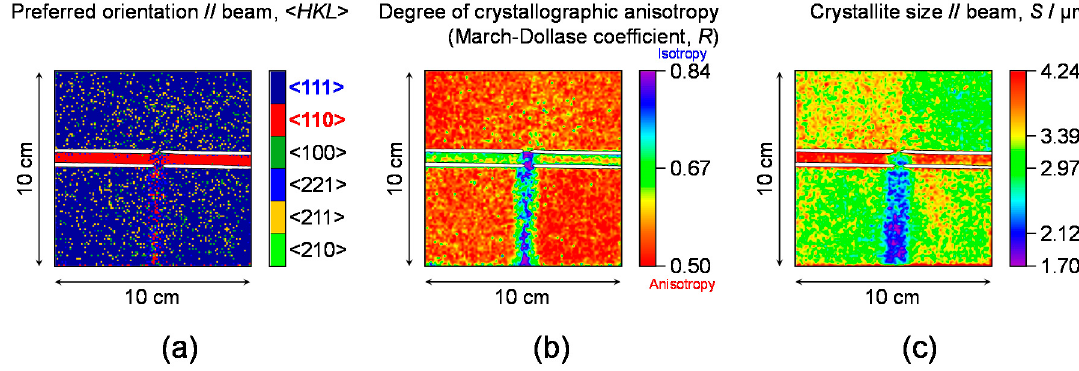
Figure 6. Quantitative imaging results of ( a ) preferred orientation parallel to neutron transmission direction, ( b ) degree of texture evolution and ( c ) crystallite size averaged along neutron transmission direction [1,7].